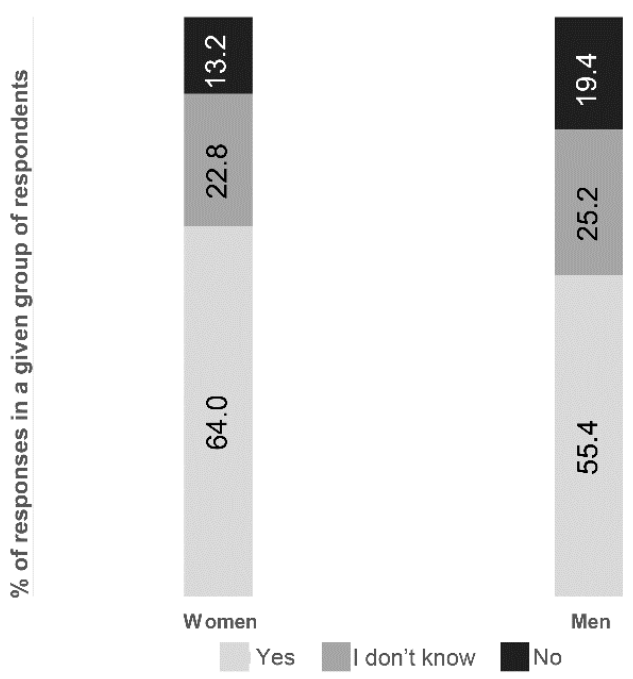
Figure 5. Evaluation of possible forms of housing for the elderly.